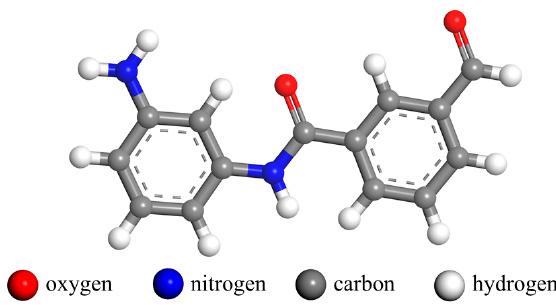
Figure 1. Molecular elemental structure of meta-aramid fiber.